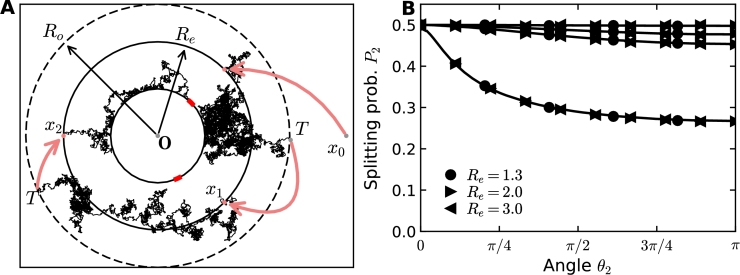
Simulation results are independent of the choice of entering radius Re and outer radius Ro. (A) Two windows are placed on a disk. Brownian particles originating from the source at x0 are injected at the circumference of the circle with radius Re. Trajectories leaving the region with radius Ro are restarted at a radius Re. (B) Varying the exit radius Re and Ro does not change the splitting probability (flux) from simulations. The box plot shows the distribution of errors in the flux to window 2. The error is defined as the deviation of the flux from the mean over all observed radii combinations (Re,Ro) and all angles θ2, but separately for all source distances L. Note that there are no systematic deviations when changing either Re or Ro.